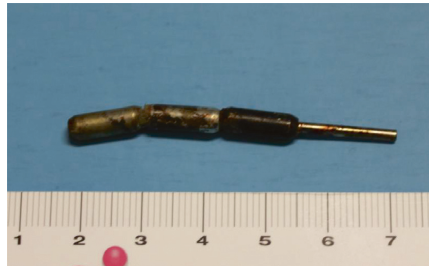
Figure 3: Magnets removed by the